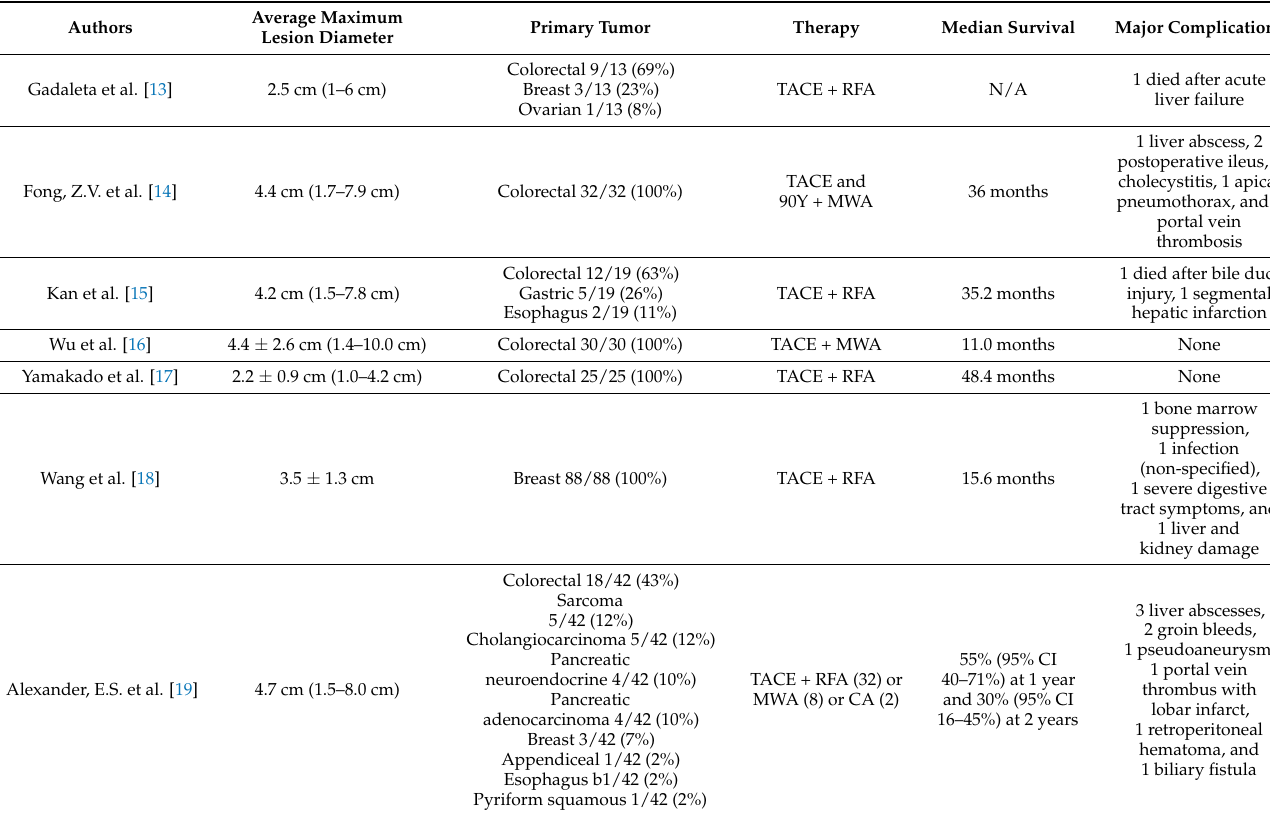
Table 2. Characteristics of the studies included in the review (part